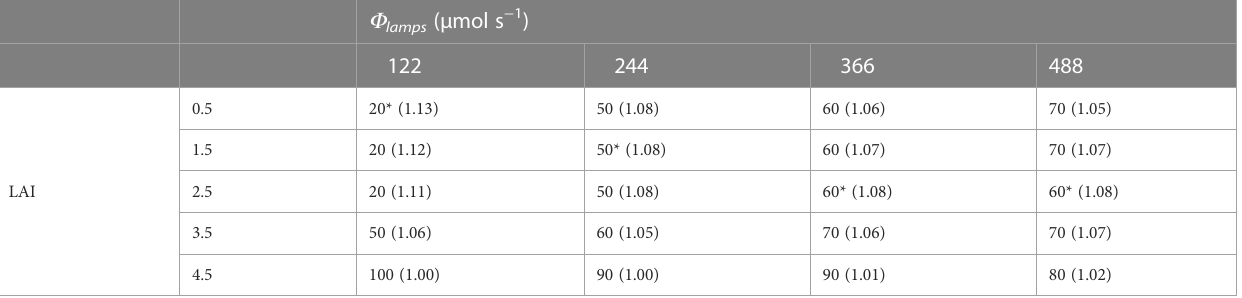
TABLE 2 The proportion ( p dw ; %) of the photosynthetic photon fl ux of lamps for downward lighting to that of whole lamps for downward and upward lighting ( F lamps ) that maximize the net photosynthetic rates of the komatsuna canopy in each condition of the leaf area index (LAI) and F lamps